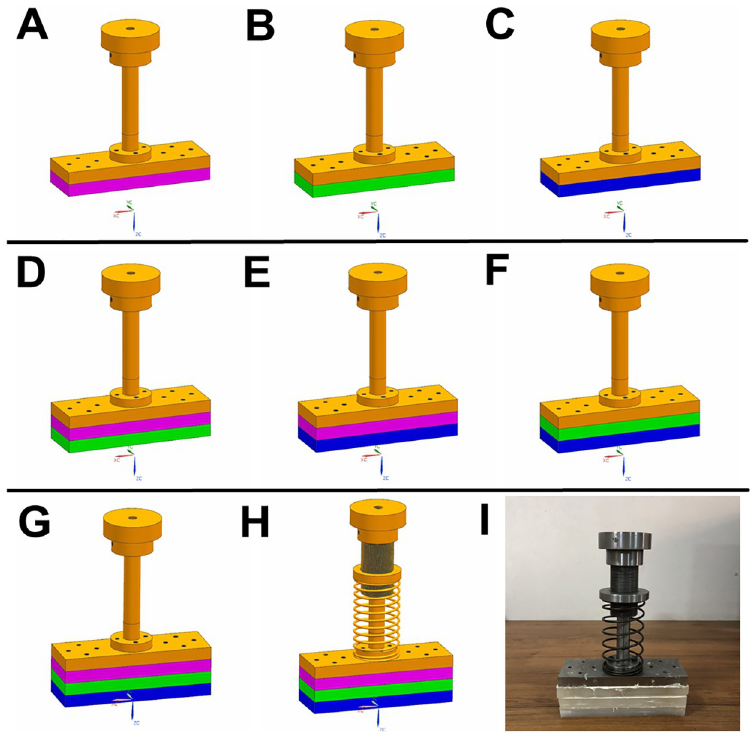
Fig 2. Design of different bio-inspired feet. Yellow (45# steel plate): the phalange layer; pink (15 HA silicon rubber): the digital cushion layer; green (35 HA silicon rubber): the fascia layer; blue (55 HA silicon rubber): the skin layer. (A —C), (D—F), (G): bio-inspired feet assembled with single-, double-, and three-layer silicon rubbers, respectively; (H) the bio-inspired foot added with spring (stiffness coefficient = 6 N � mm -1 ) to simulate the functions of MTP joint; (I) a bio-inspired foot used in the